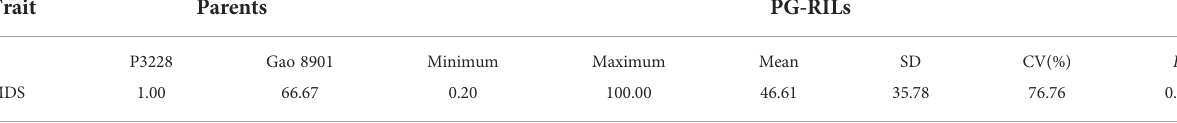
TABLE 1 Phenotypes of the parents and PG-RIL population in this